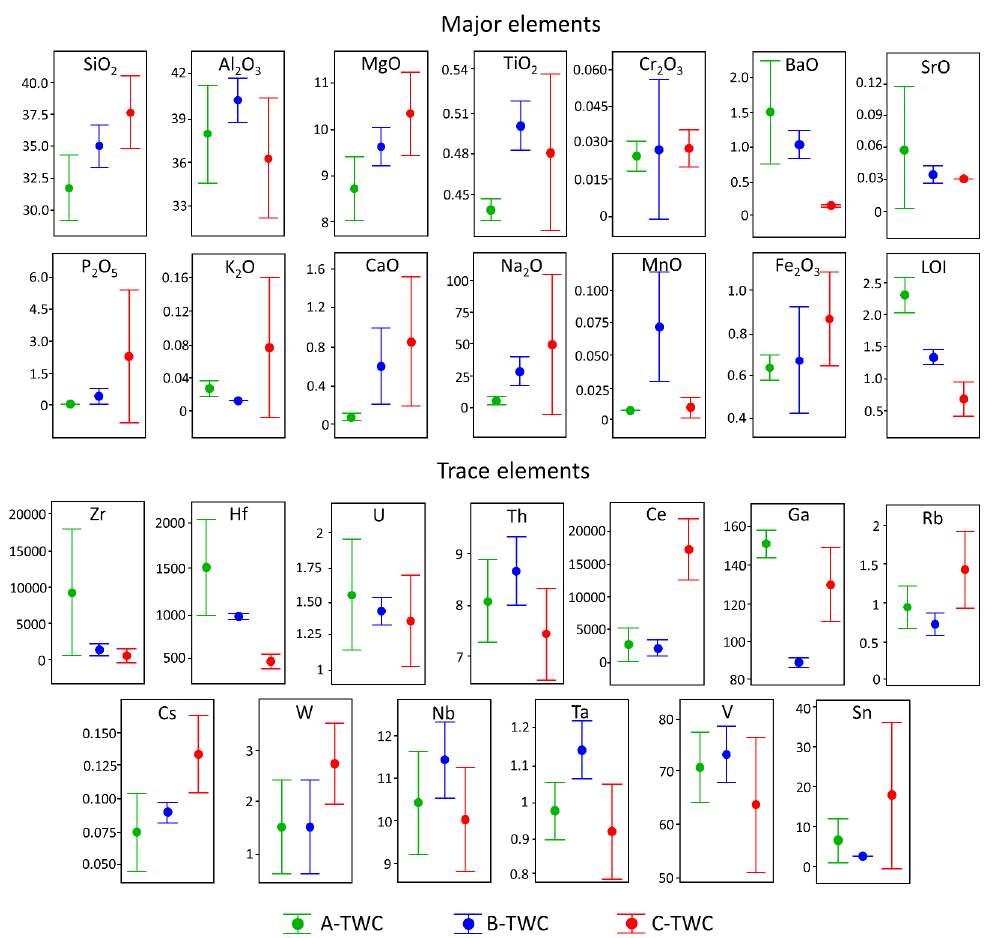
Figure 2. Boxplot of the major (wt%, vertical axis) and trace elements concentrations (ppm, vertical axis) of the studied samples. 95% CI for the mean, individual standard deviations were used to calculate the intervals.